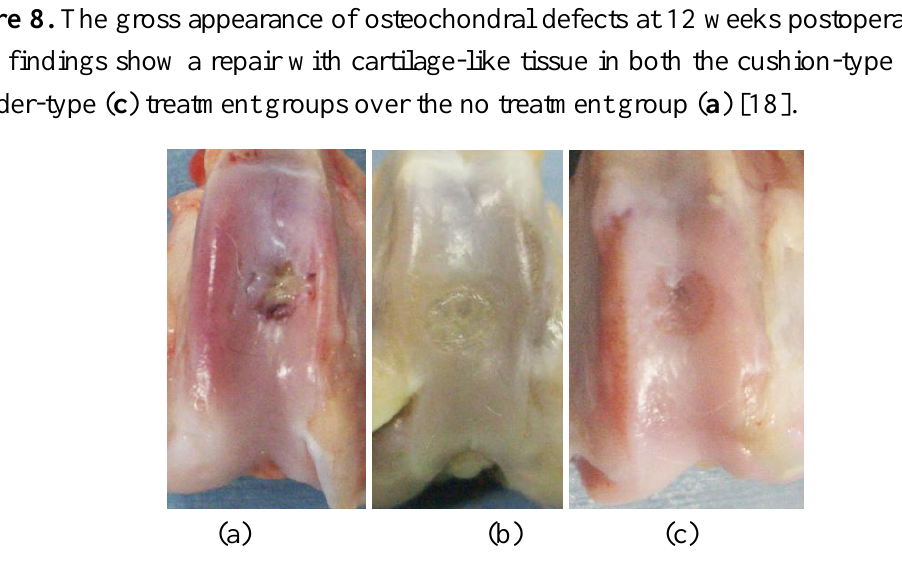
Figure 9. Histological and immunohistochemical appearance of the osteochondral defect in the patellar groove of rabbit knee joint at 12 weeks postoperatively. Safranin-O staining ( a , c , e ) and immunohistochemical staining with antitype II collagen ( b , d , f ) demonstrate the rich production of GAGs and type II collagen in the reparative tissue of both the cushion-type treatment group (c, d) and the cylinder-type treatment group (e, f), compared to the no treatment group (a, b). Scale bars indicate 1 mm